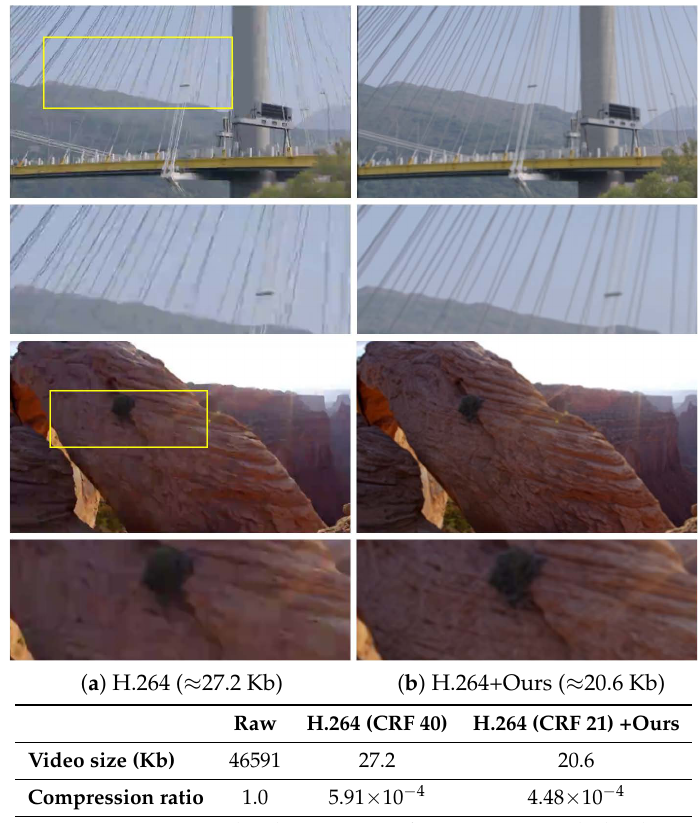
Figure 7. Comparison to video compression. Visual contrast between the ( a ) H.264 compressed frame and ( b ) our generated frame from H.264 compressed frame. We adjust the compressed video size to be similar by tuning the constant rate factor (CRF) to investigate the quality difference at limited bandwidth scenarios. For comparison, the H.264 reference uses CRF = 40, while CRF = 21 is used when applying our method. The magnified regions are denoted as yellow